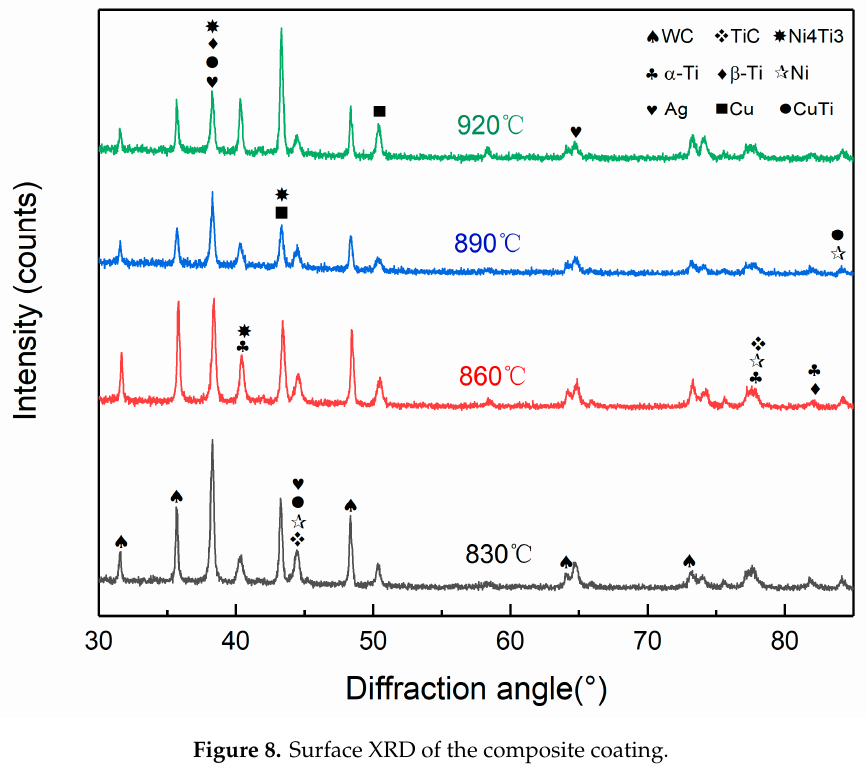
Figure 8. Surface XRD of the composite coating.